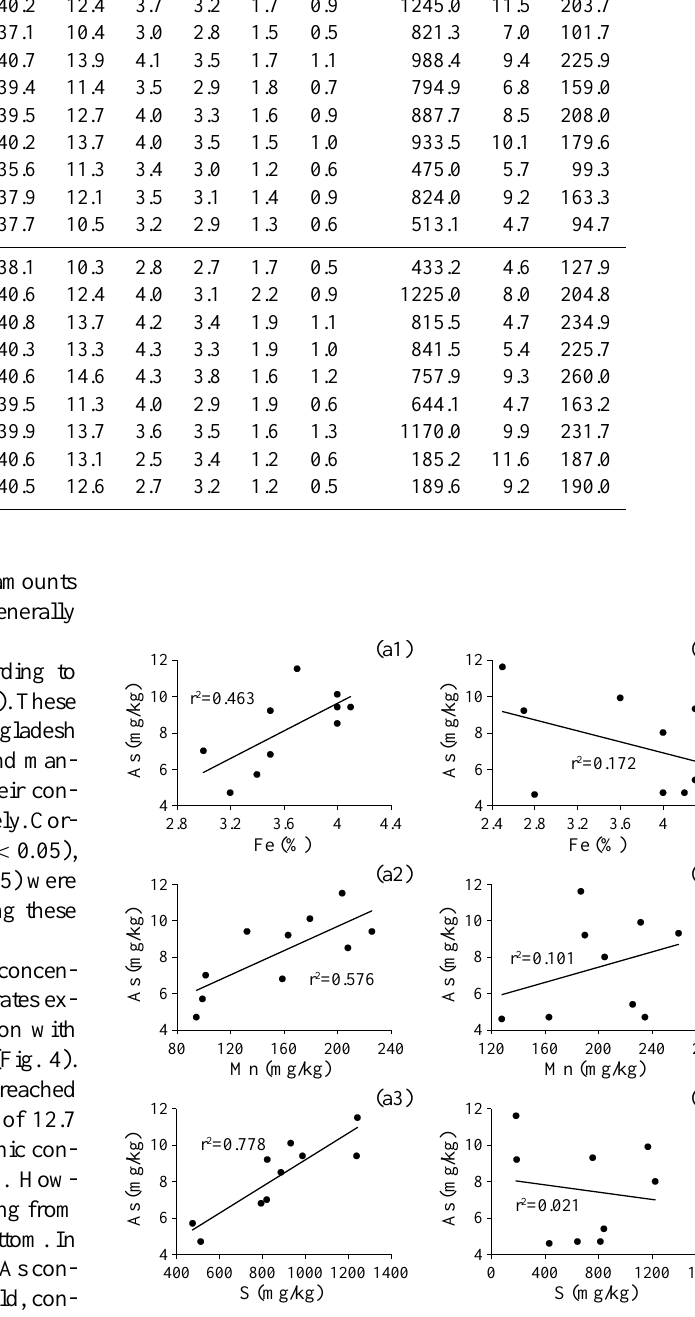
Fig. 5. Relationships of As between Fe, Mn, and S in the solid phase of (a) YL6-1 and (b)